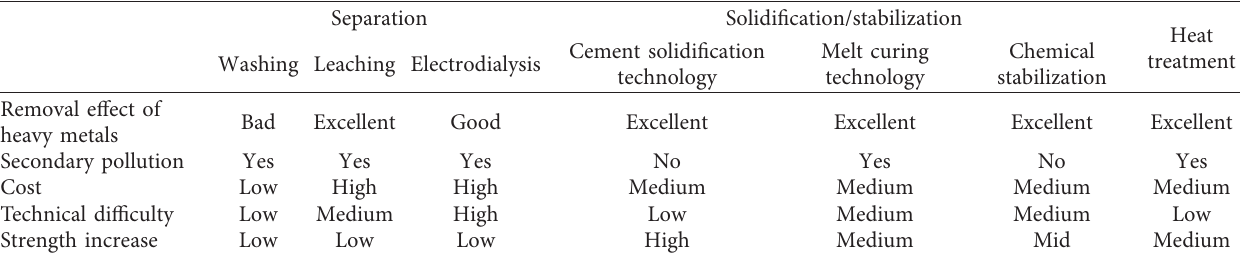
Table 4: Pretreatment methods of MSWI fly ash and bottom ash.